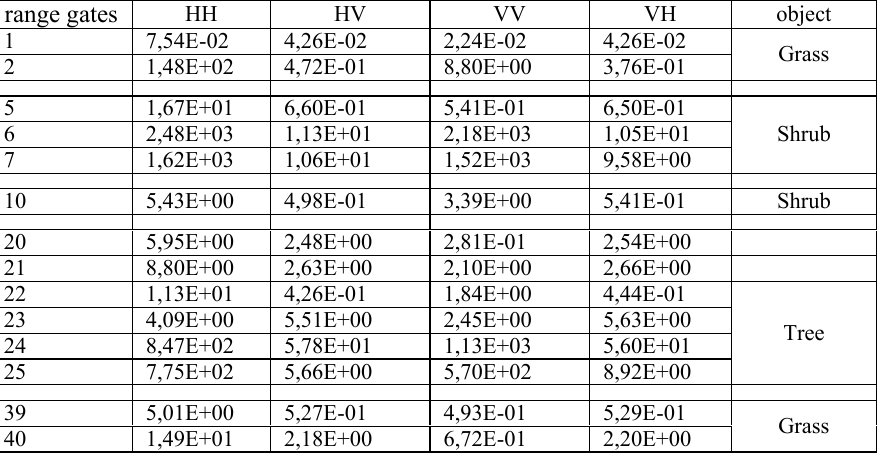
Table 5. The results of the calculation of the RCS values in the scene without a target, only the background. range gates